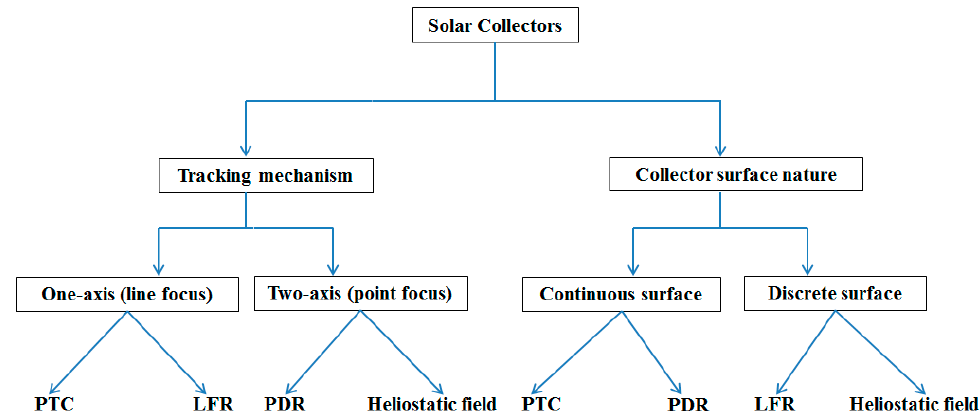
Figure 4. Classification of CSP technologies.